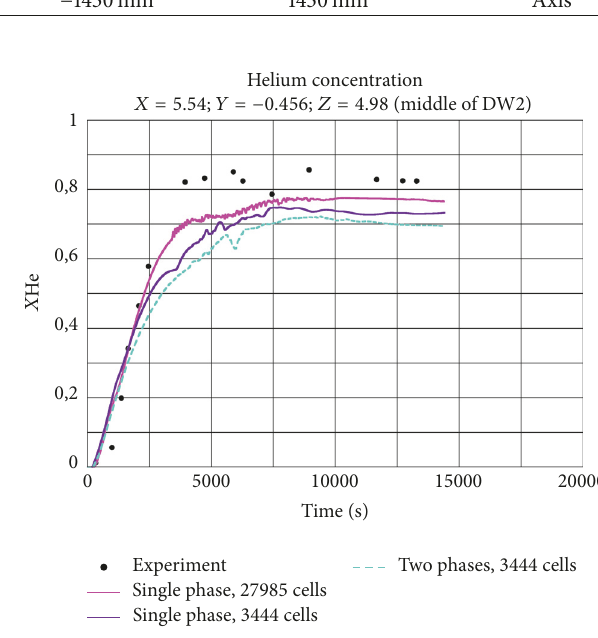
Figure 13: Helium concentration at the middle of DW2.